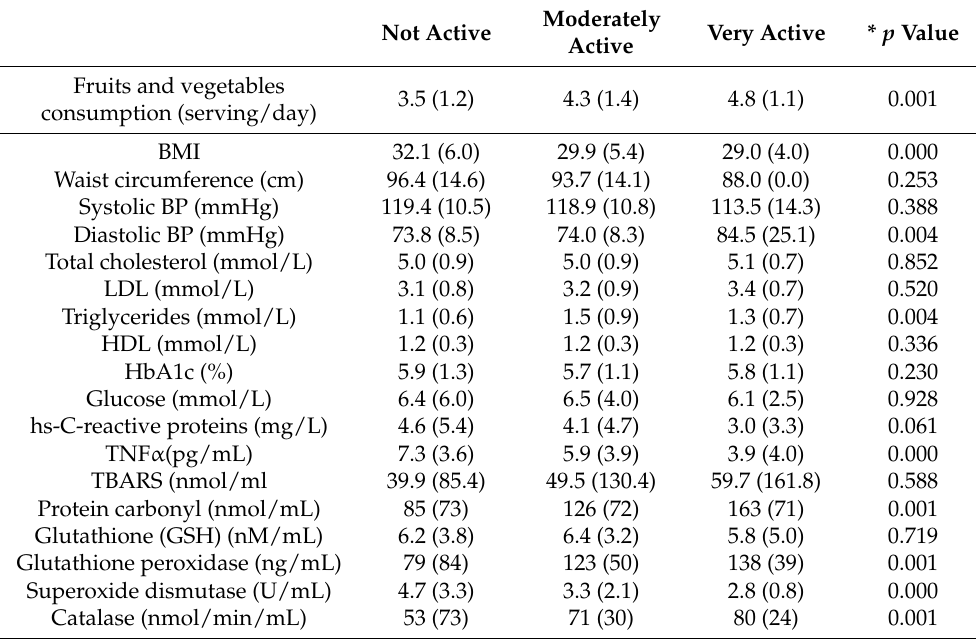
Table 4. Follow up anthropometric, BP, lipids, antioxidants and markers of oxidative damage and in- flammation according to physical activity levels at leisure times, mean (SD%), unless stated otherwise.